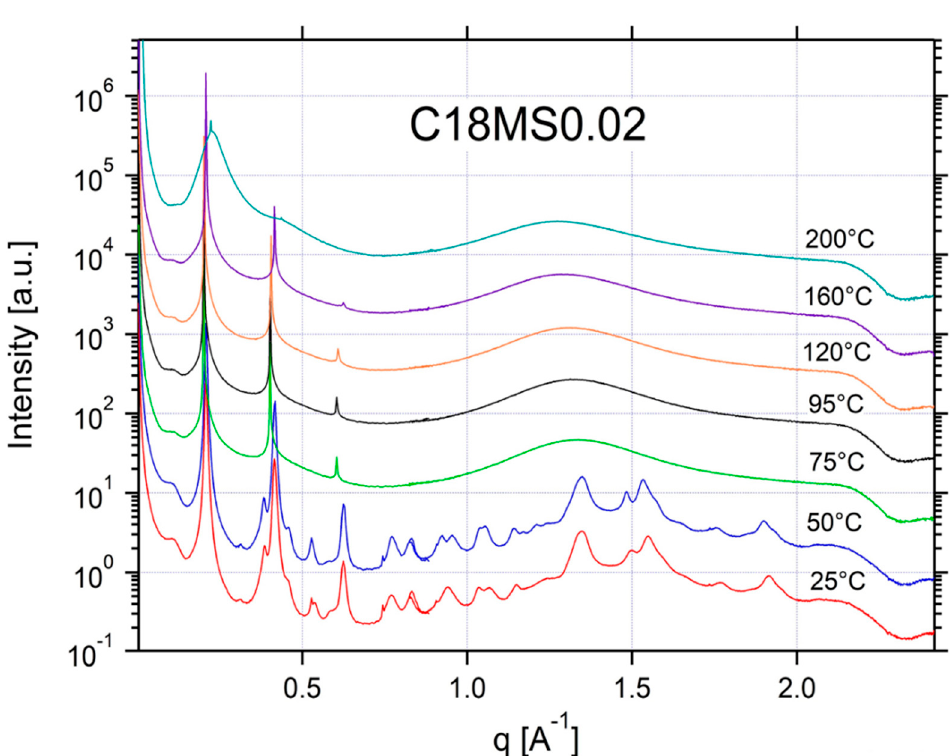
Figure A10. SAXS and WAXS data for 0.02:1 C18MS:C18LiTFSI.